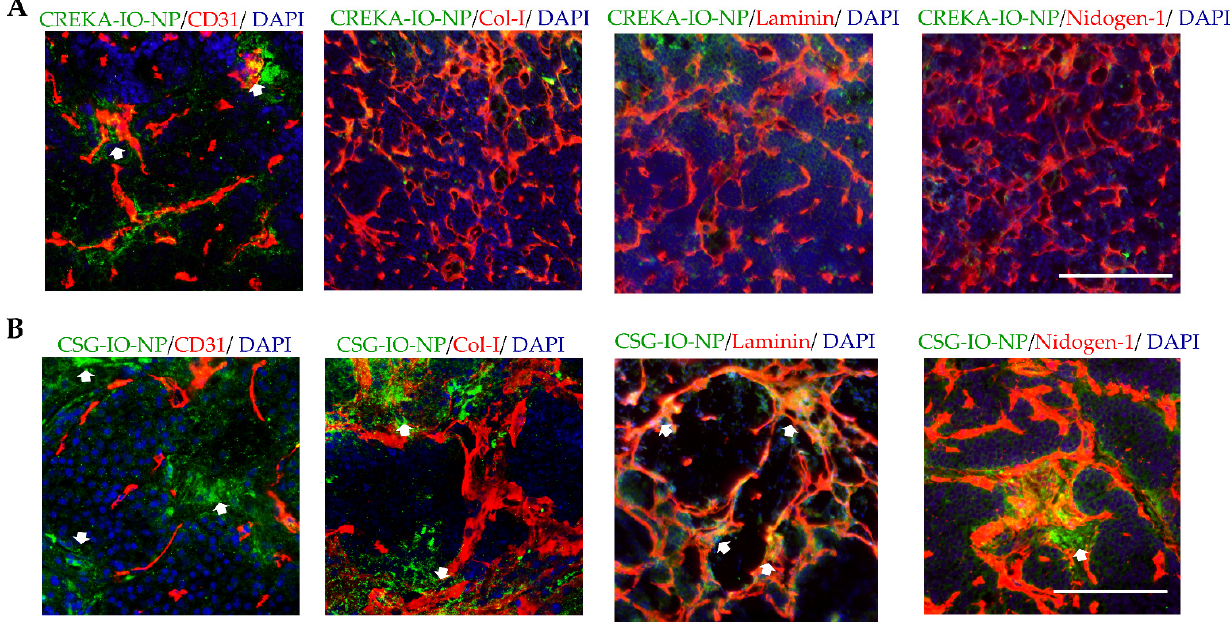
Figure 5. RIP1-Tag5 tumours with ( A ) CREKA-IO-NP and ( B ) CSG-IO-NP (green) were co-stained with CD31 (red), collagen I (Col-1, red), laminin (red) or nidogen-1 (red), and nuclei were stained with DAPI (blue). Representative micrographs are shown with indicated detection of IO-NP accumulation (arrows). Scale bars, 50 µm.